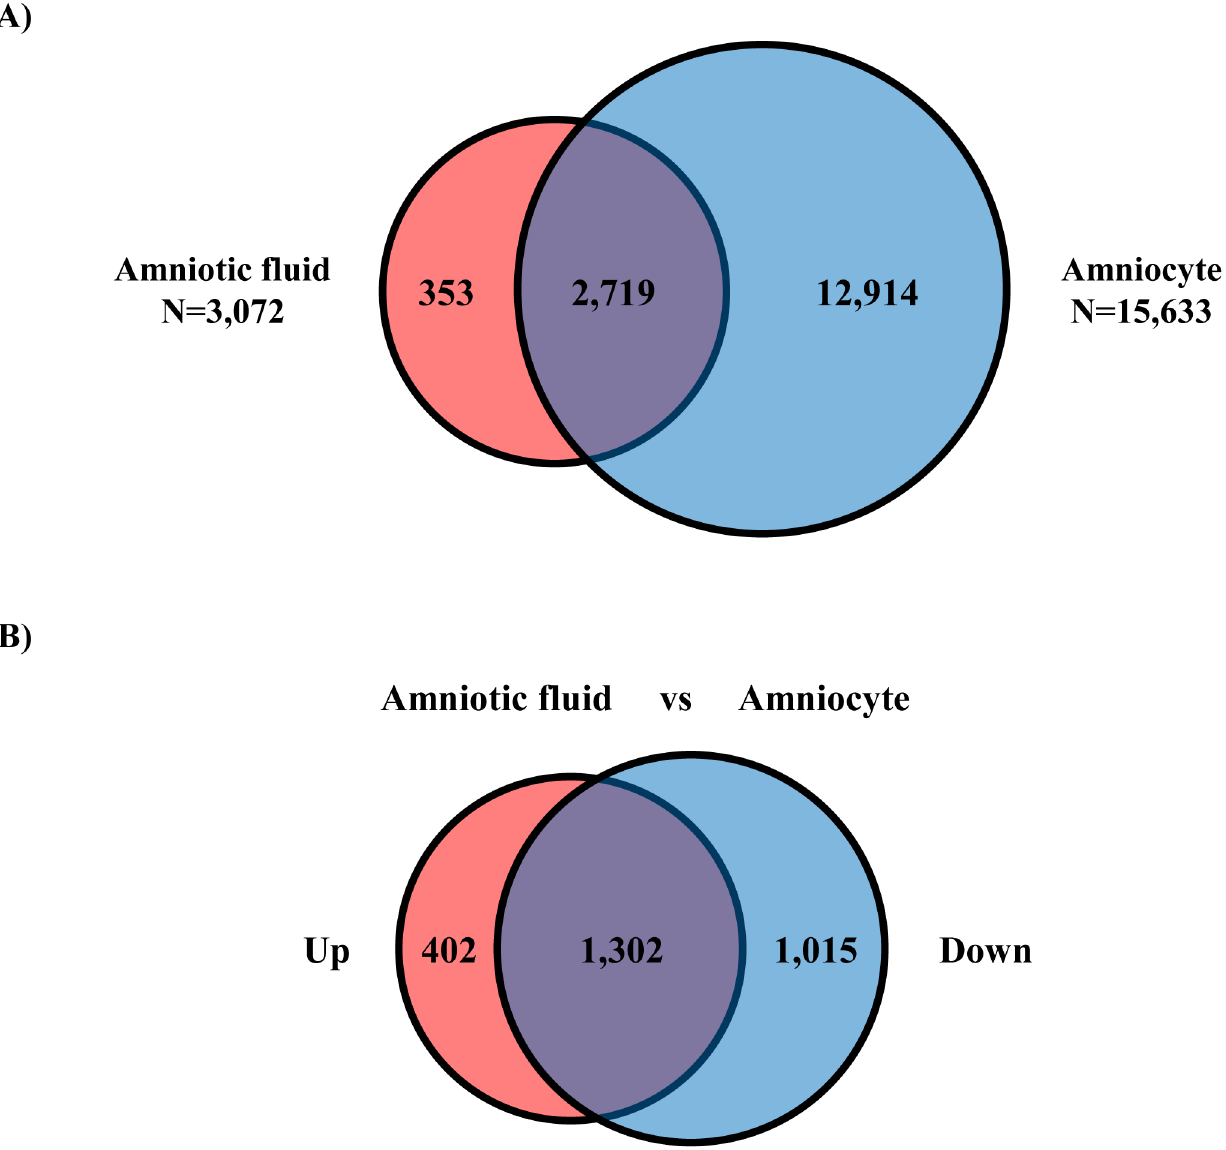
Fig 2. A. Venn diagram of the numbers of genes detected in the AFS and amniocytes by comparative transcriptome analysis. B. Venn diagram showing the numbers of up- and down-regulated genes that overlapped between the AFS and amniocytes.